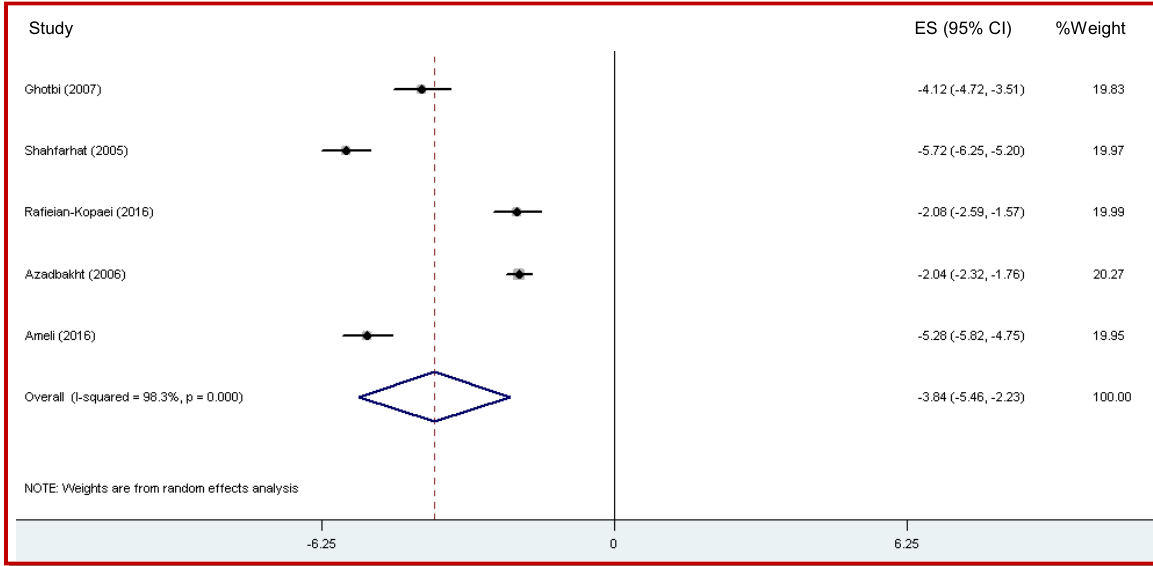
Figure 5: Forest plot Standardized Mean Difference (Hedges method) of within arm control (phototherapy alone or phototherapy + placebo) in 36 hours after the intervention versus